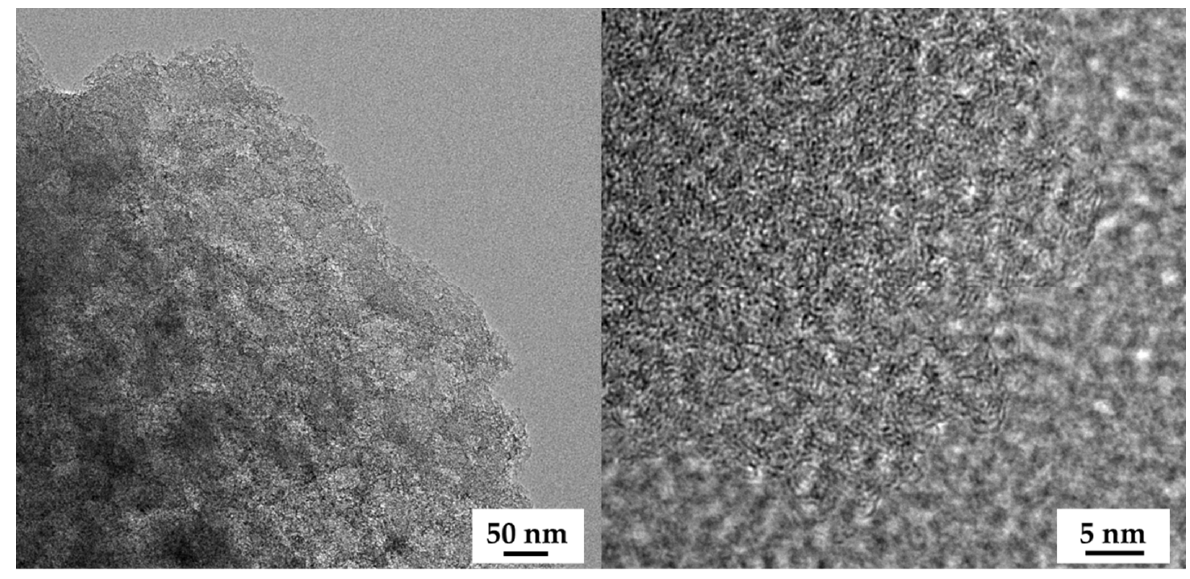
Figure 3. FE-TEM images of OPL − KOH − 800 − 1:4.